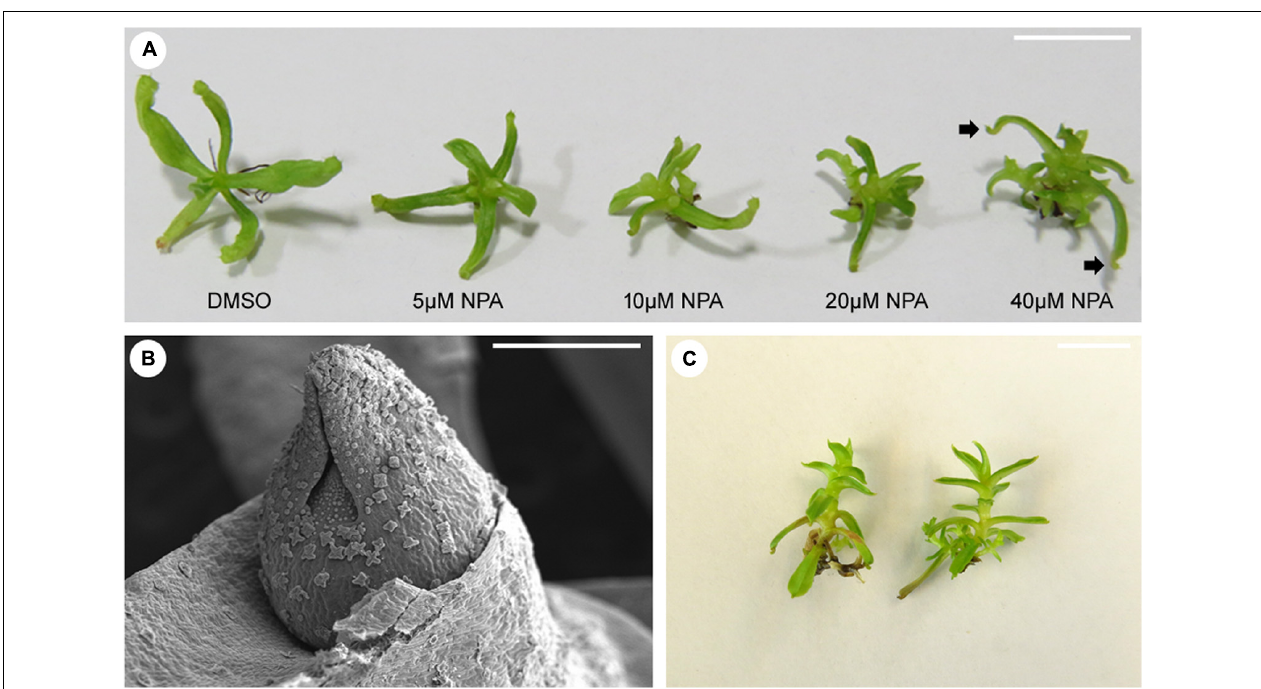
FIGURE 3 | Effects of auxin transport inhibition and nutrient availability on pitcher formation in N. khasiana . (A) Morphological phenotypes of N. khasiana plantlets after 1 month of treatment with varying concentrations of NPA (arrow points to tiny structures at the tip of the leaf). (B) A scanning electron micrograph of an axillary bud of N. khasiana , arising as a result of NPA treatment. (C) N. khasiana plantlets grown in 2 MS (twice the strength of full MS i.e., 1 MS). Note the dramatic changes in leaf morphology. (A,C) Bar = 10 mm; (B) bar = 0.5